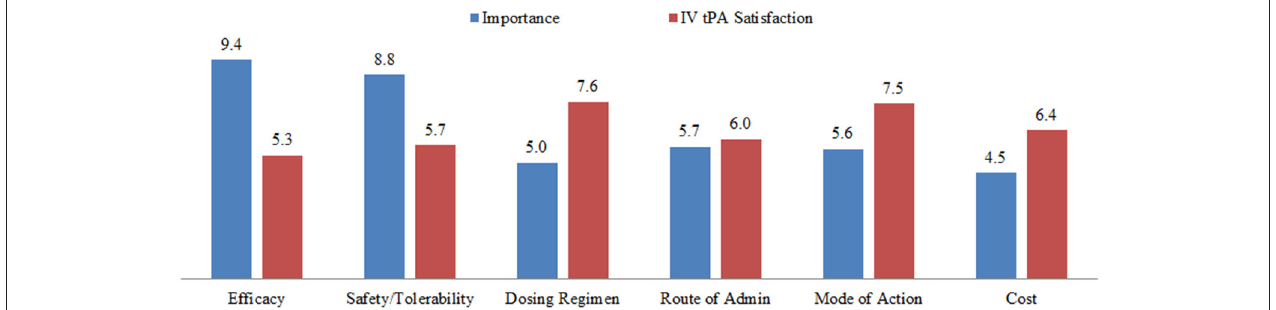
FIGURE 5 | Unmet medical needs concerning physician satisfaction with tPA therapy in the United States and Europe. IV, intravenous; tPA, tissue plasminogen activator. The terms in the figure were provided to the physician interviewees without further definitions, and interviewees were asked to rank each term on a 10-point scale. For importance: 0 = unimportant and 10 = essential. For satisfaction: 0 = fully unsatisfactory and 10 = entirely satisfactory. The numbers are mean responses of the 32 interviewees.